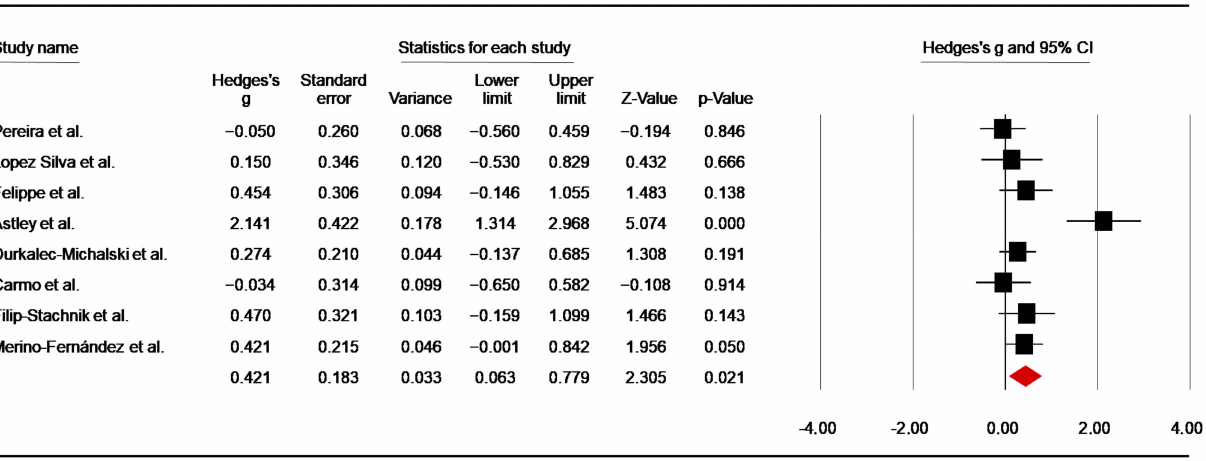
Figure 4. Forest plot of the effect of caffeine intake on SJFT number of throws [45,47,50–52,55,57,58]. SJFT-Index